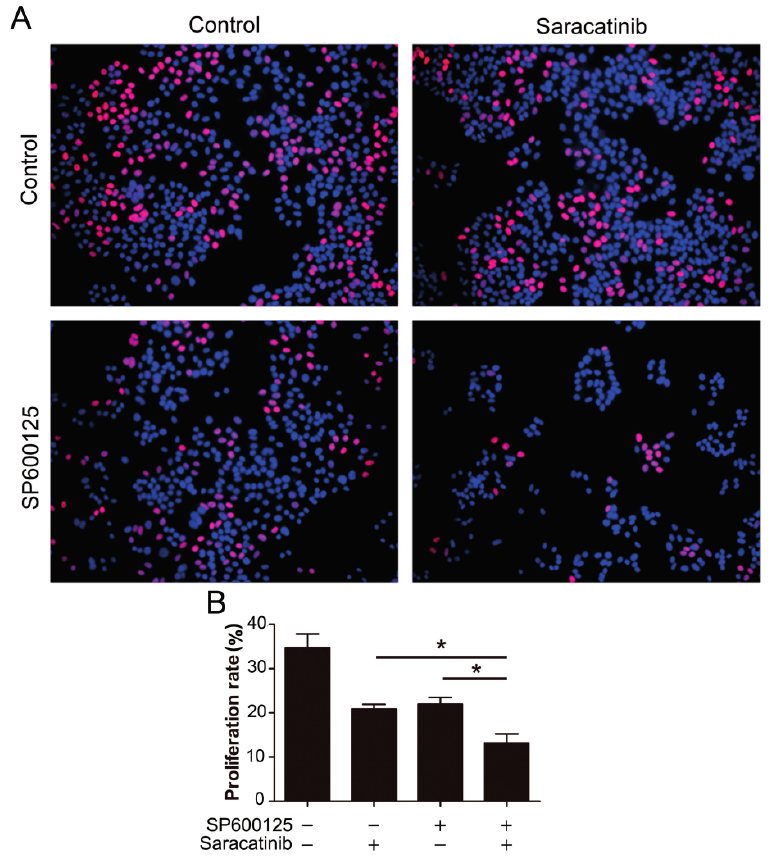
Figure 5. Combination of SP600125 and saracatinib synergistically inhibits HepG2 cell proliferation. ( A ) HepG2 cells were pretreated with 5 µM SP600125 for 3 h and then treated with or without 10 µM SP600125 for 48 h, followed by EdU